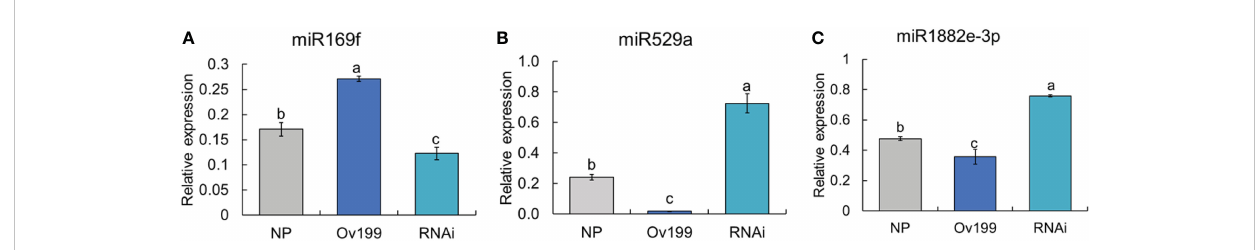
FIGURE 5 The results of RT-qPCR of miRNAs in NP, Ov199 and RNAi. (A) Expression of miR169f in NP, Ov199 and RNAi. (B) Expression of miR529a in NP, Ov199 and RNAi. (C) Expression of miR1882e-3p in NP, Ov199 and RNAi. Error bars: SD (n = 4). Signi fi cant differences between different lines are indicated by different letters ( P < 0.05, one-way ANOVA).